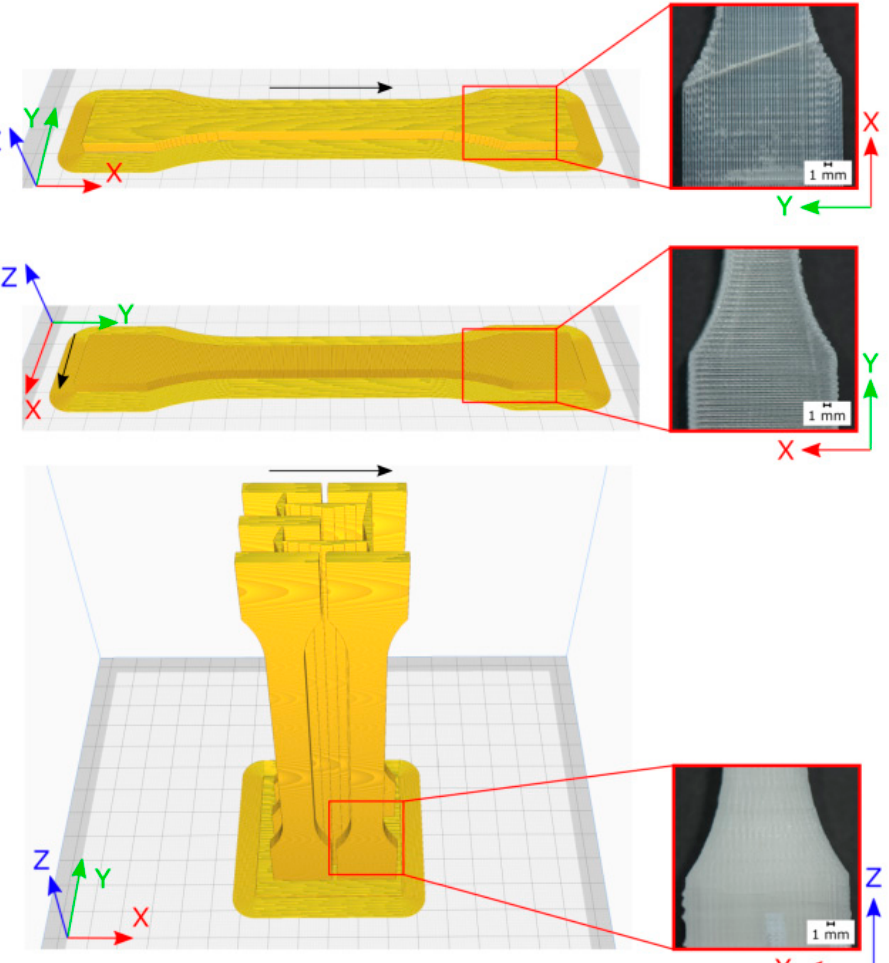
Figure 8. Printed tensile bars with coordinate system ( left ) and the related visual quality ( right ), black arrow shows printing direction.